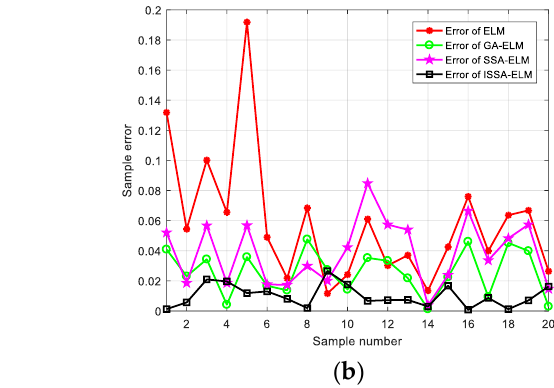
Figure 7. Comparison of experimental results. ( a ) Predicted value; ( b ) Error comparison.